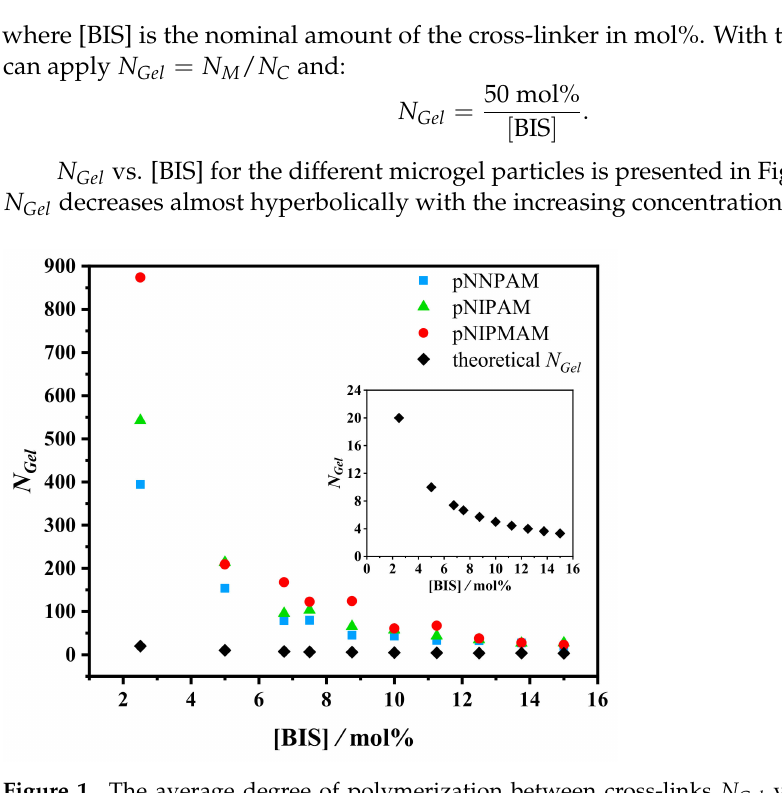
Figure 1. The average degree of polymerization between cross-links N Gel vs. concentration of N,N’ -methylenebisacrylamide (BIS) in p(NNPAM) (blue), p(NIPAM) (green), and p(NIPMAM) (red) particles. The parameter N Gel was calculated using the Flory–Rehner Equation (2) with the Hill- like Equation (6) for the interaction parameter χ . The theoretical N Gel (black) was calculated with Equation (5). To better see the hyperbolic dependence between N Gel and [BIS], the theoretical N Gel is shown in the inset. More details will be discussed